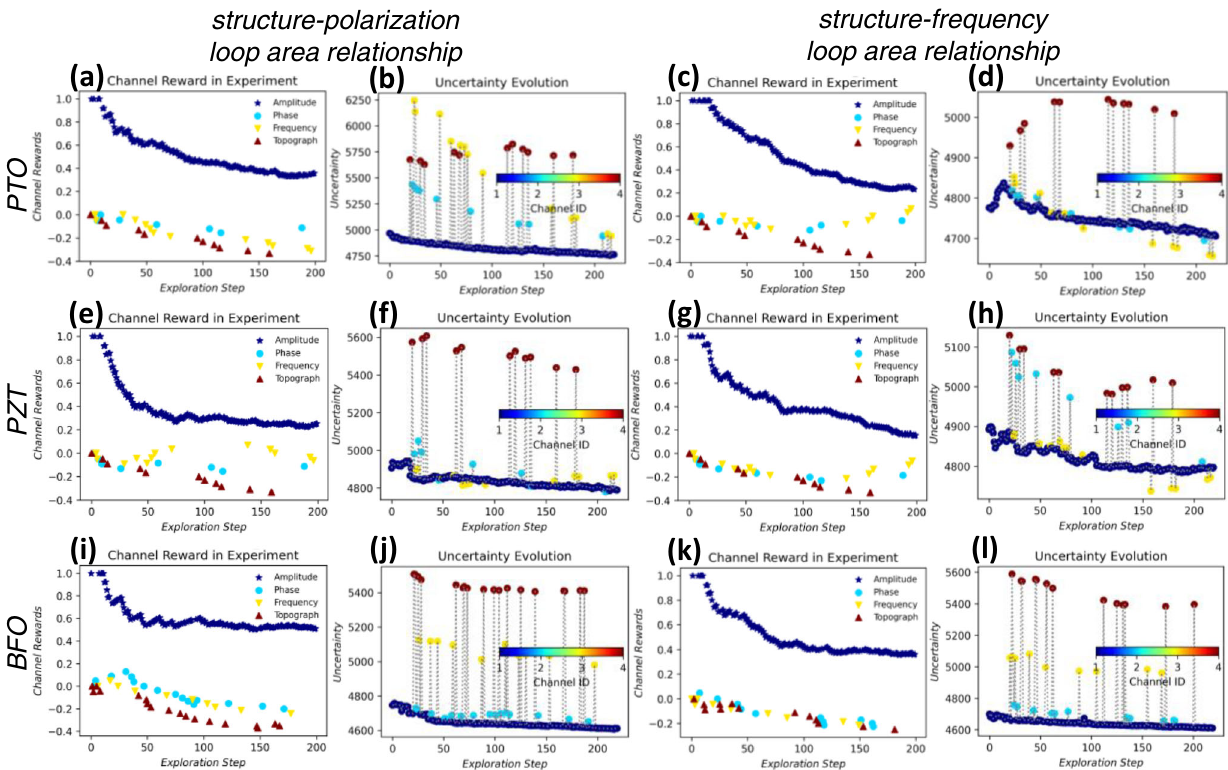
Fig. 3 Experimental process of three model samples when the functional property is set as polarization loop area and resonance frequency loop area. a – l Results for PTO, PZT, and BFO samples, respectively. The fi rst and second columns show the evolution of channel reward and the mean predictive uncertainty as a function of experimental steps for the ensemble DKL when the functional property is a polarization loop area. In this case, ensemble DKL identi fi es the channel with best structure-polarization loop area relationship. The third and fourth columns show the evolution of channel reward and the mean predictive uncertainty as a function of experimental steps for the ensemble DKL when the functional property is resonance frequency loop area. In this case, the ensemble DKL identi fi es the channel with best structure-frequency loop area relationship. In these measurements, the ensemble DKL analysis starts with 0.25% of total number of points available for measurements and use 20 warm-up states. During the warm-up states, all four channels are evaluated in parallel and the one with the lowest uncertainty is used for next evaluation point. After the warmup phase, we sample a single channel at each step based on the epsilon-greedy policy with epsilon decreased uniformly from 0.4 to 0.1 during the 200 steps. In the uncertainty evolution plots, the color represents the selected channel at a speci fi c step, which allows us to visualize the correlation of channel selection and uncertainty